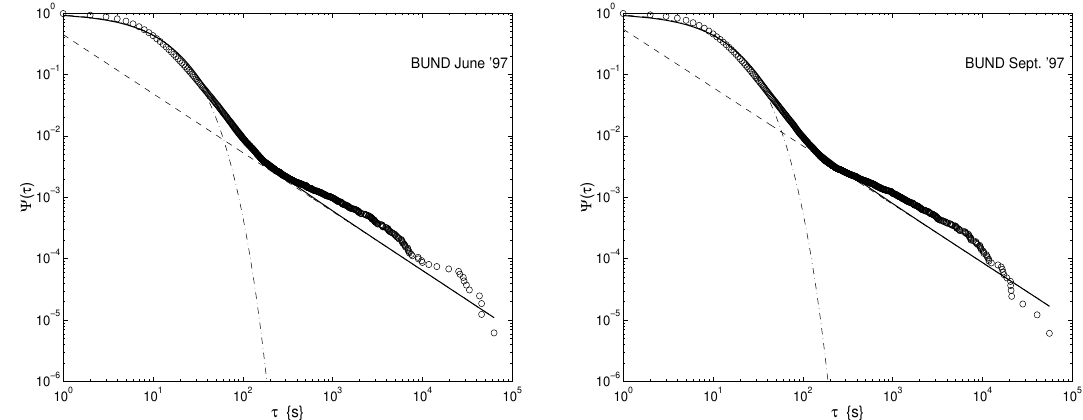
Figure 1. Survival probability for BUND futures with delivery date: June 1997 ( left ) September 1997 ( right ). The Mittag-Leffler function (solid line) is compared with the stretched exponential (dash-dotted line) and the power (dashed line) functions: { β = 0.96, γ = 1/12} ( left ); { β = 0.95, γ = 1/12)} ( right ).